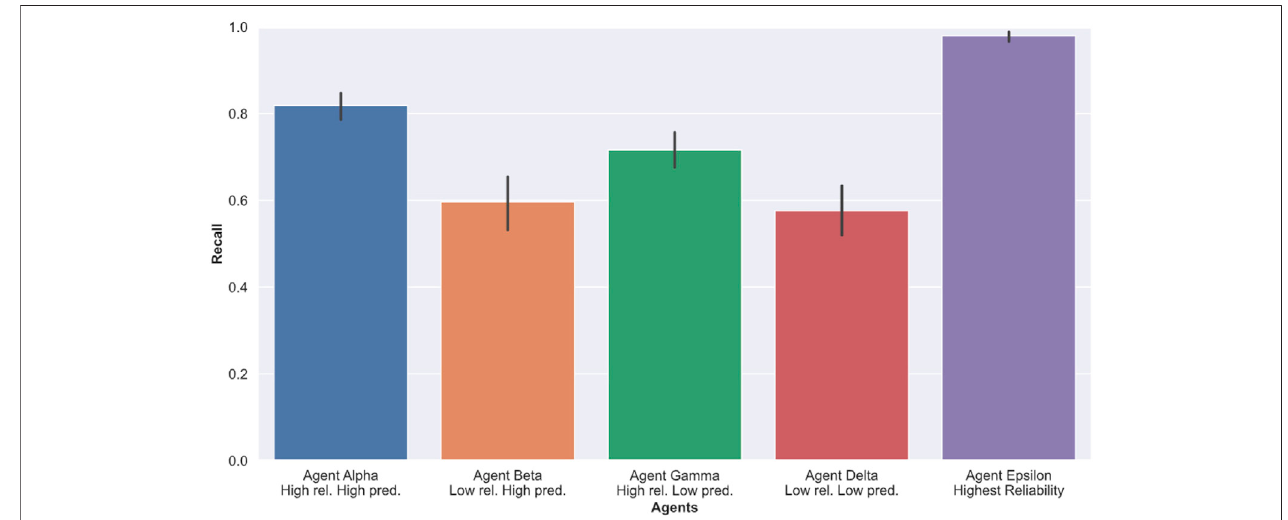
FIGURE 5 | Average Recall scores for each session with agents. A higher score indicates better performance.